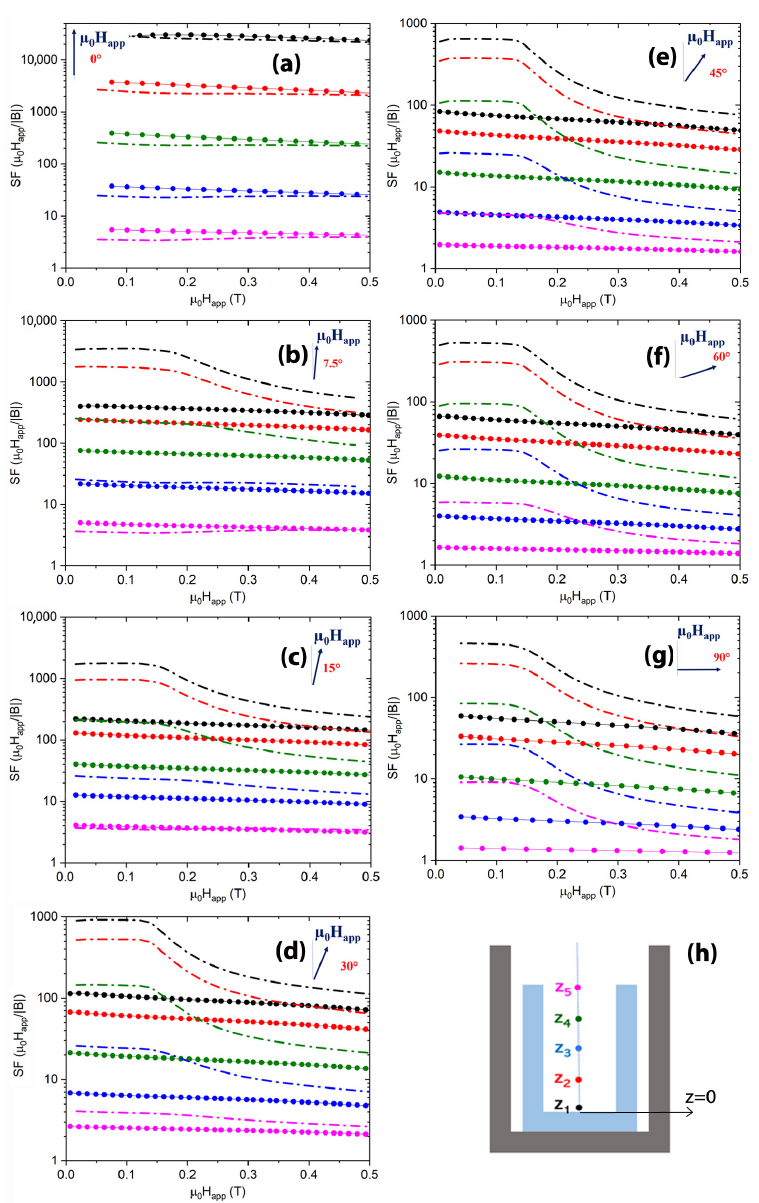
Figure 10. Comparison between the SFs of the single SC cup (dot symbols) and of the configuration HCC3 (dash dot lines). Each frame ( a – g ) corresponds to a different tilt angle of the applied magnetic field. Assuming z = 0 the axial coordinate of the close extremity of the SC cup, the curves refer to positions z 1 = 1.0 mm (black curves), z 2 = 5.0 mm (red curves), z 3 = 9.2 mm (green curves), z 4 = 13.7 mm (blue curves), and z 5 = 18.3 mm (magenta curves), indicated in the HCC3 schematic view shown in the frame ( h